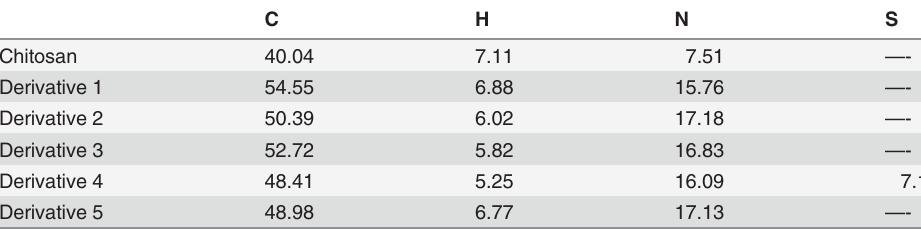
Table 1. Elemental analysis of chitosan and